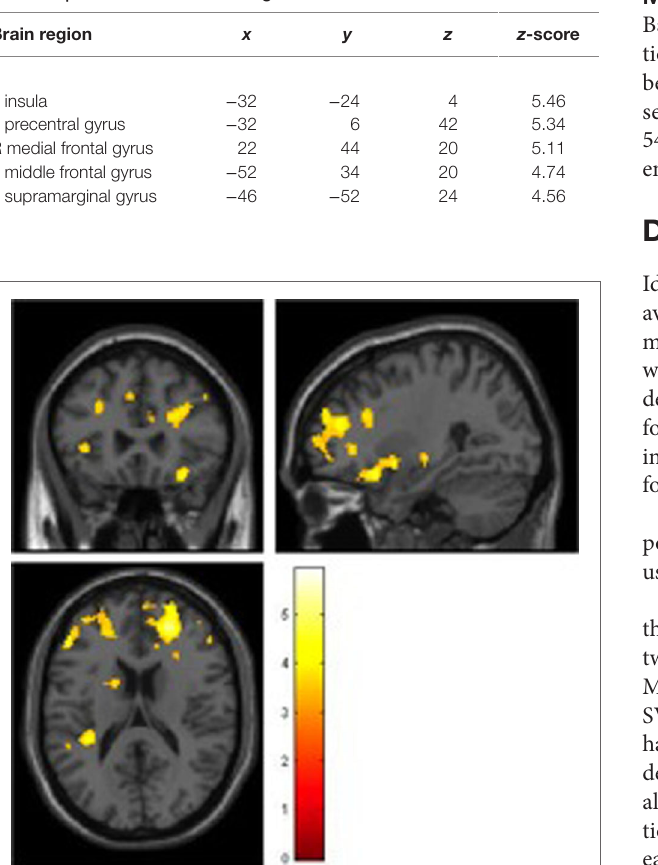
TaBle 2 | Main effect of